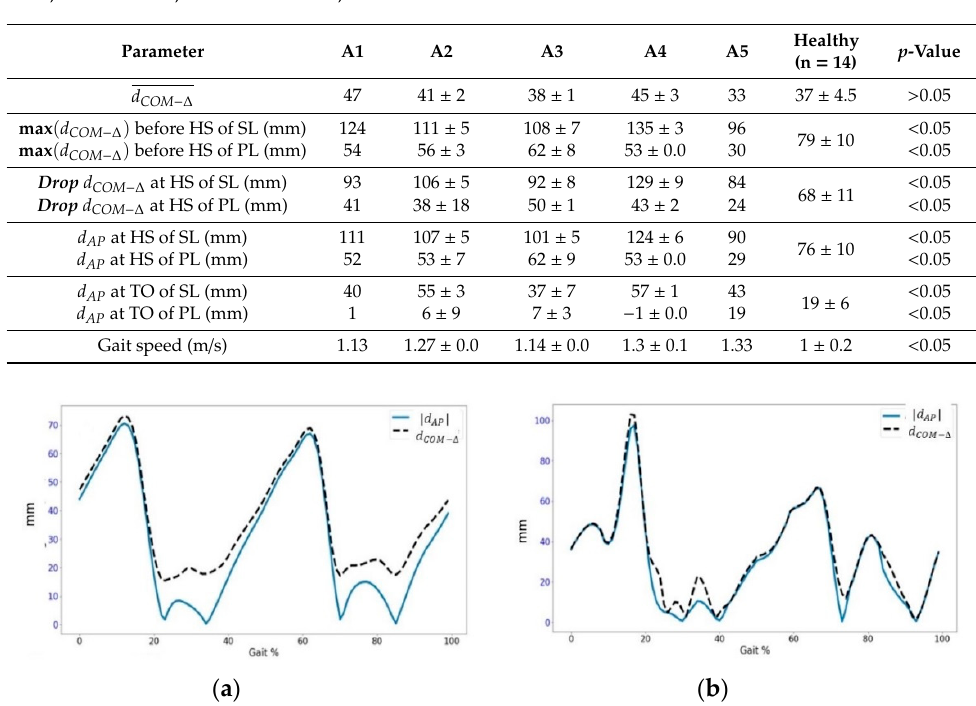
Table 2. Calculated parameters among amputees (A1, A2, A3, and A4) and healthy subjects. HS: Heel Strike, TO: Toe O ff , SL: Sound limb, PL: Prosthetic limb.